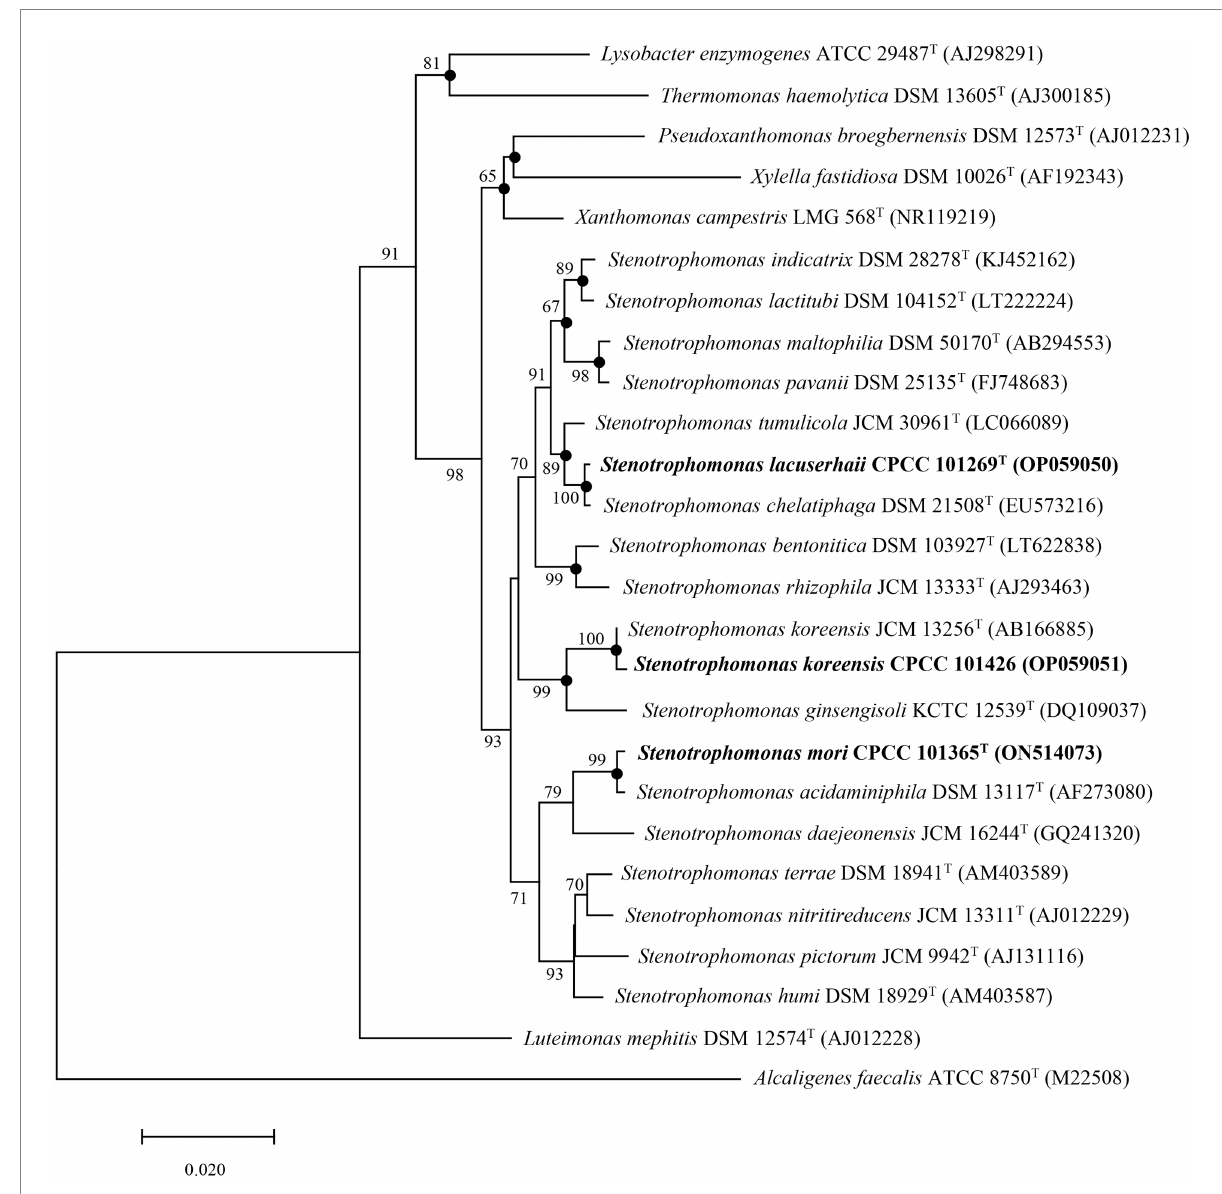
FIGURE 1 Neighbor-joining tree based on 16S rRNA gene sequences showing the relationships of strains CPCC 101269 T , CPCC 101365 T , and CPCC 101426 with other representatives of the family Lysobacteraceae . Filled circles indicate that the corresponding nodes were also recovered in phylogenetic trees generated using Maximum Likelihood and Maximum Parsimony methods. Bootstrap values above 50% are shown as percentages of 1,000 replicates. Alcaligenes faecalis ATCC 8750 T (GenBank accession M22508) was used as the outgroup. Scale bar indicates 0.02 nt substitutions per alignment